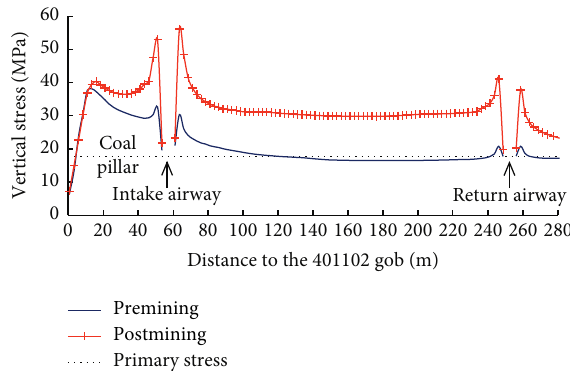
Figure 5: Contrast curve of abutment pressure between premining and postmining of the working face.